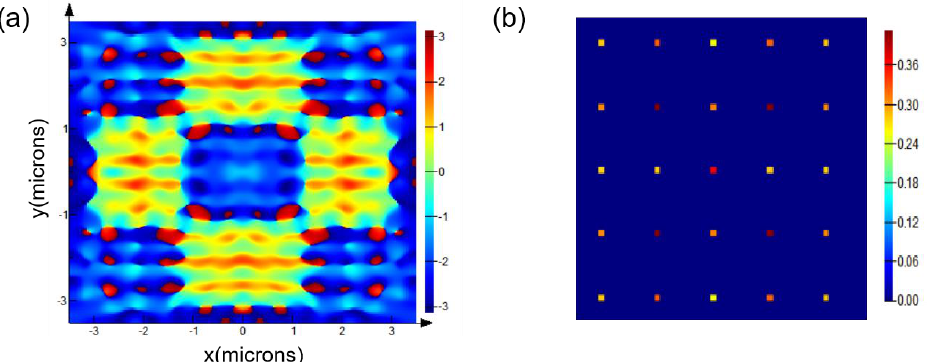
Figure 4. ( a ) Electric field phase distribution of Ex of the transmitted field in the xy plane. ( b ) Nor- malized diffractive intensity distribution in the far − field of the straight waveguides DG with two radii of R 1 = 140 nm and R 2 = 183 nm with x − pol light incident. The color bars show the phase and intensity distribution change in ( a ) and ( b ), respectively.